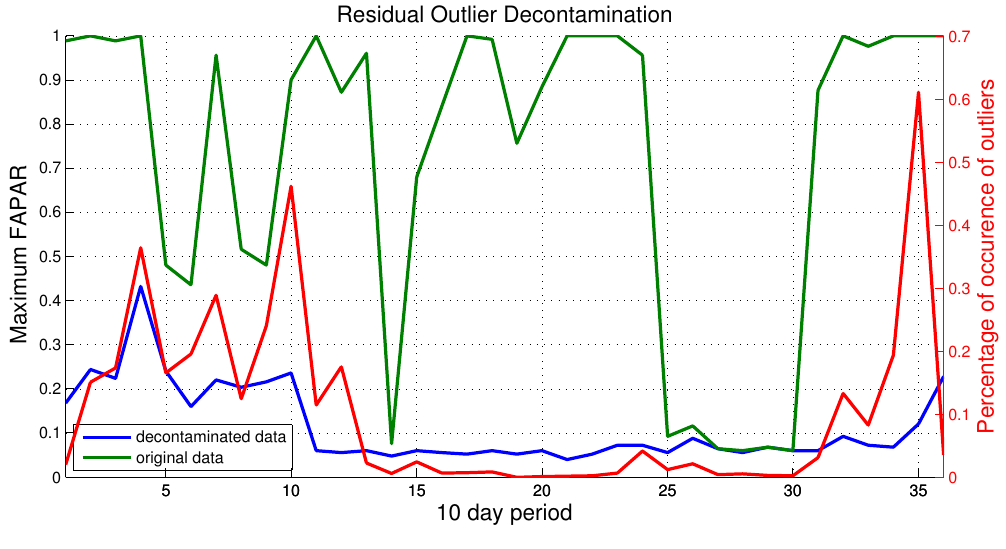
Figure 4. Example of the residual outlier decontamination: plot of the maximum FAPAR over a target area (box 30 ◦ N–35 ◦ N,10 ◦ W–10 ◦ E) in 1998. The plot of maximum FAPAR values over the target area before the application of the standard deviation test (green line) emphasizes the presence of outliers at each time step ( i.e. , 10-day period). Replicating the same analysis after the 3-sigma test (blue line) reveals that saturated signals have been removed. The red line represents the frequency of